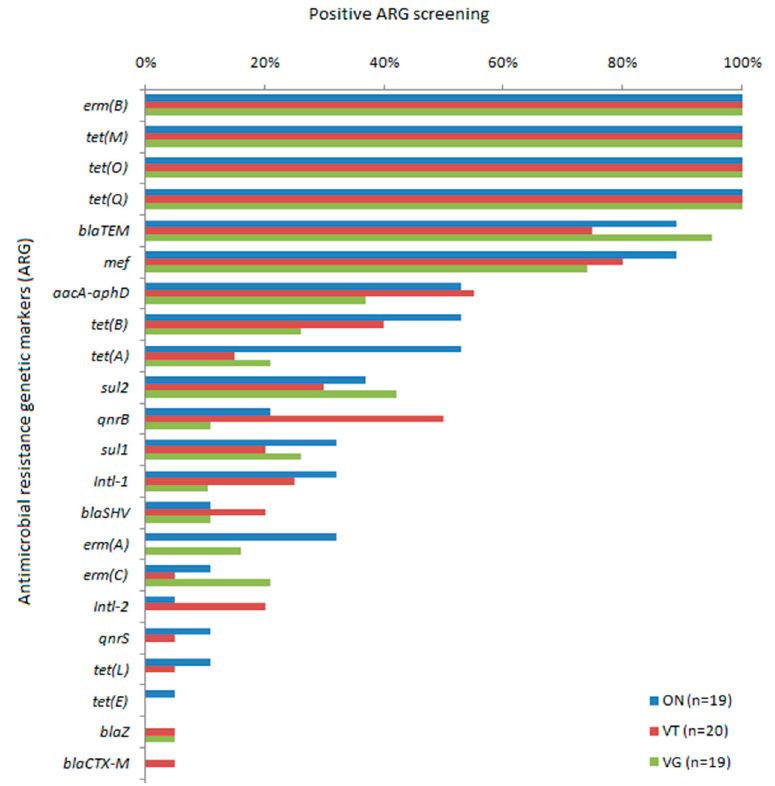
Figure 2. Distribution of 22 antimicrobial resistance genetic markers (ARG) detected out of 37 tested by PCR from the fecal metagenome of omnivores (ON), ovolactovegetarians (VT), and strict vegetarians (VG). Frequency of positive screening among each tested sample.